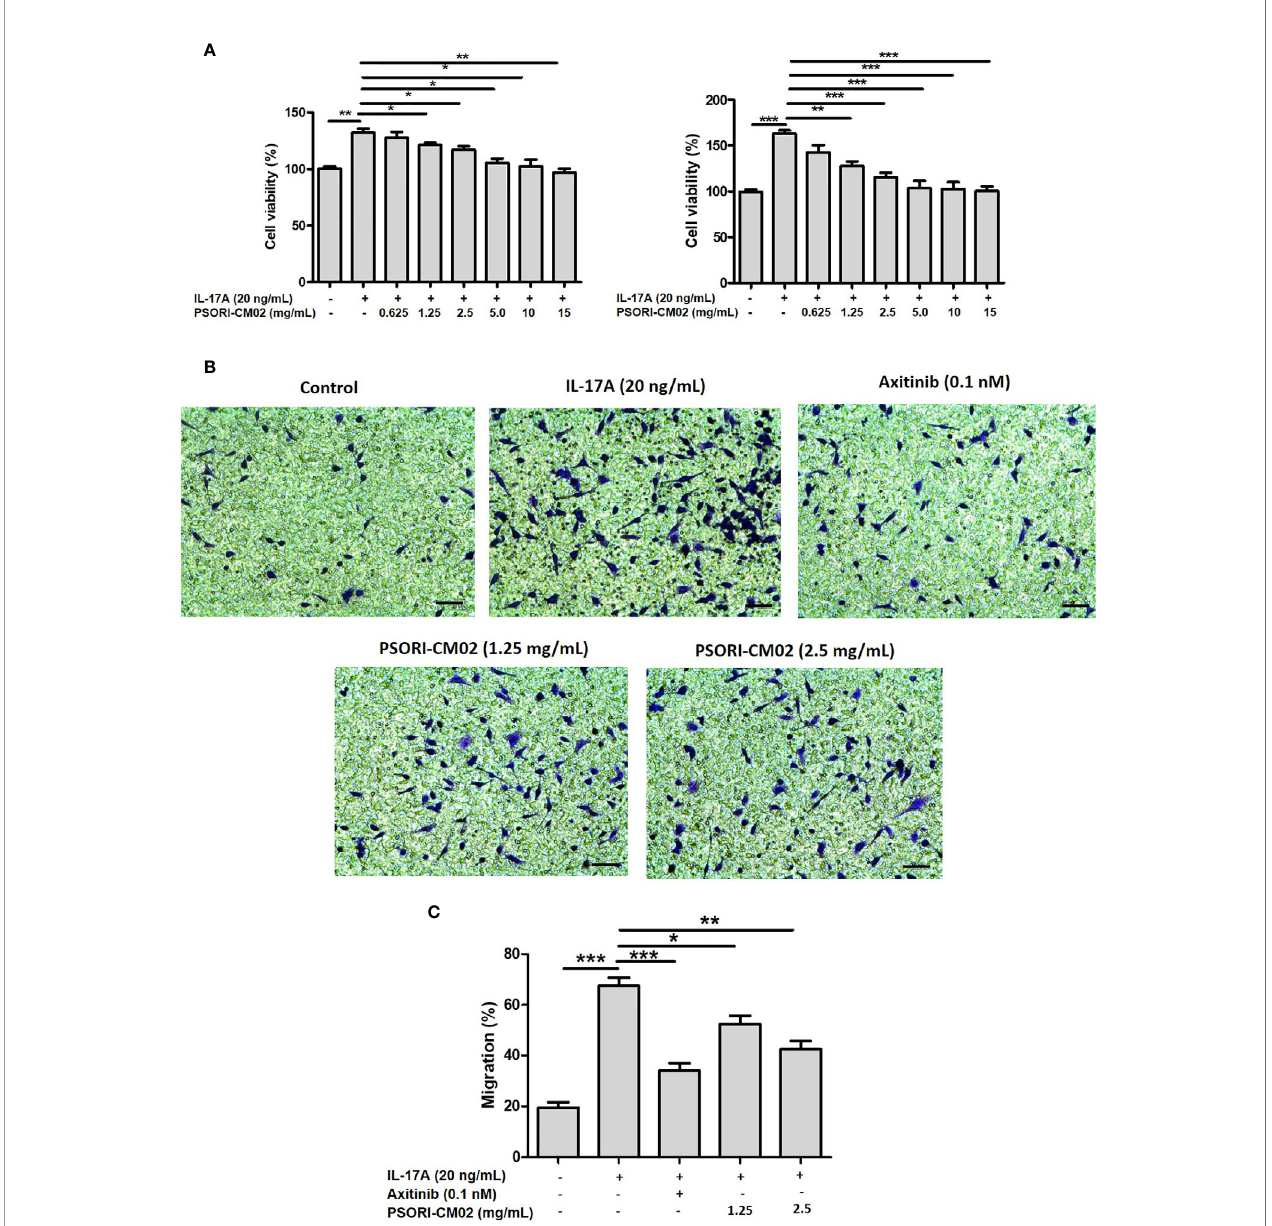
FIGURE 1 | PSORI-CM02 inhibited the proliferation and migration of interleukin (IL)-17A-stimulated human umbilical vein endothelial cells (HUVECs). (A) HUVECs were treated with various concentrations of PSORI-CM02 from 0.625 to 15 mg/mL for 24 h and 48 h, and then stimulated with 20 ng/mL IL-17A for 6 h. The effects of PSORI-CM02 on IL-17A-stimulated cell viability were assessed via MTT assay. (B) Light microscope photographs indicate cell mobility in the transwell migration experiment (×100 magni fi cation, scale bar = 50 m m). (C) Quanti fi cation of the HUVEC migration. Data represent the mean ± SEM of at least three independent experiments (* p < 0.05, ** p < 0.01, *** p < 0.001 vs . the IL-17A-stimulated HUVEC